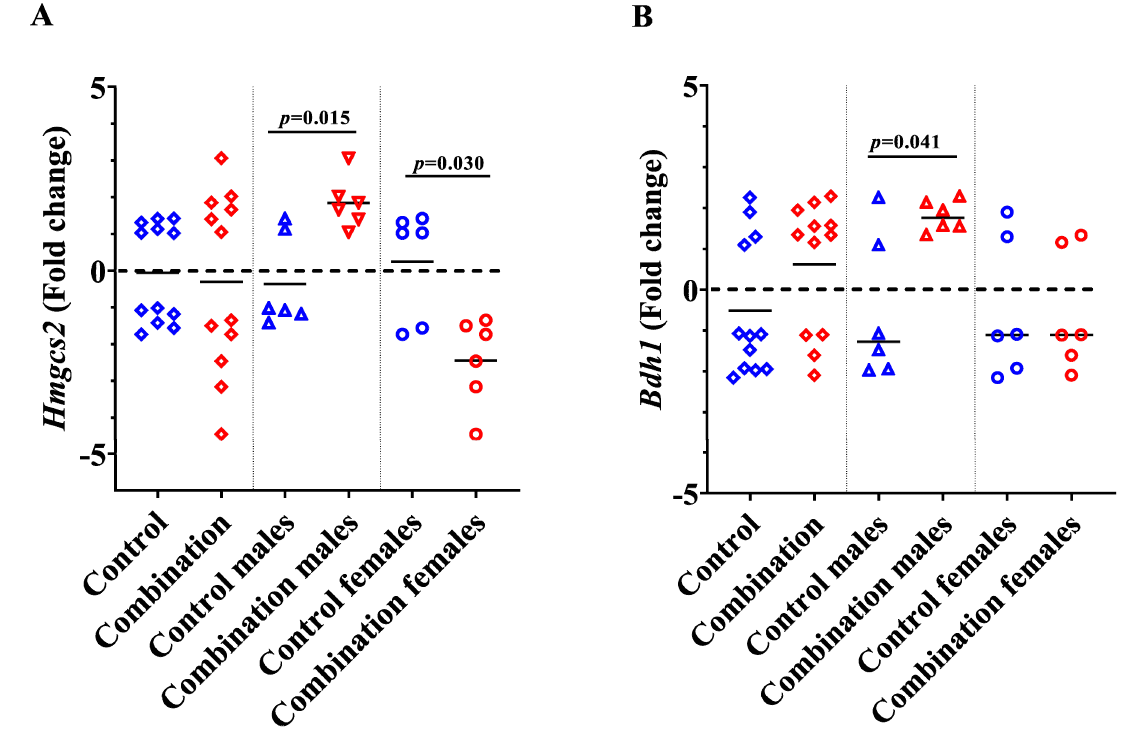
Figure 7. Expression of genes involved in ketone body metabolism increase in combination exposed males. ( A ) Expression of Hmgcs2 and ( B ) Bdh 1 in the neonatal heart of control and combination groups. Bars represents mean fold change (n = 12). Blue color indicate controls and red color indicate combination exposed. Bars represent mean fold change and the significance accepted at p < 0.05.